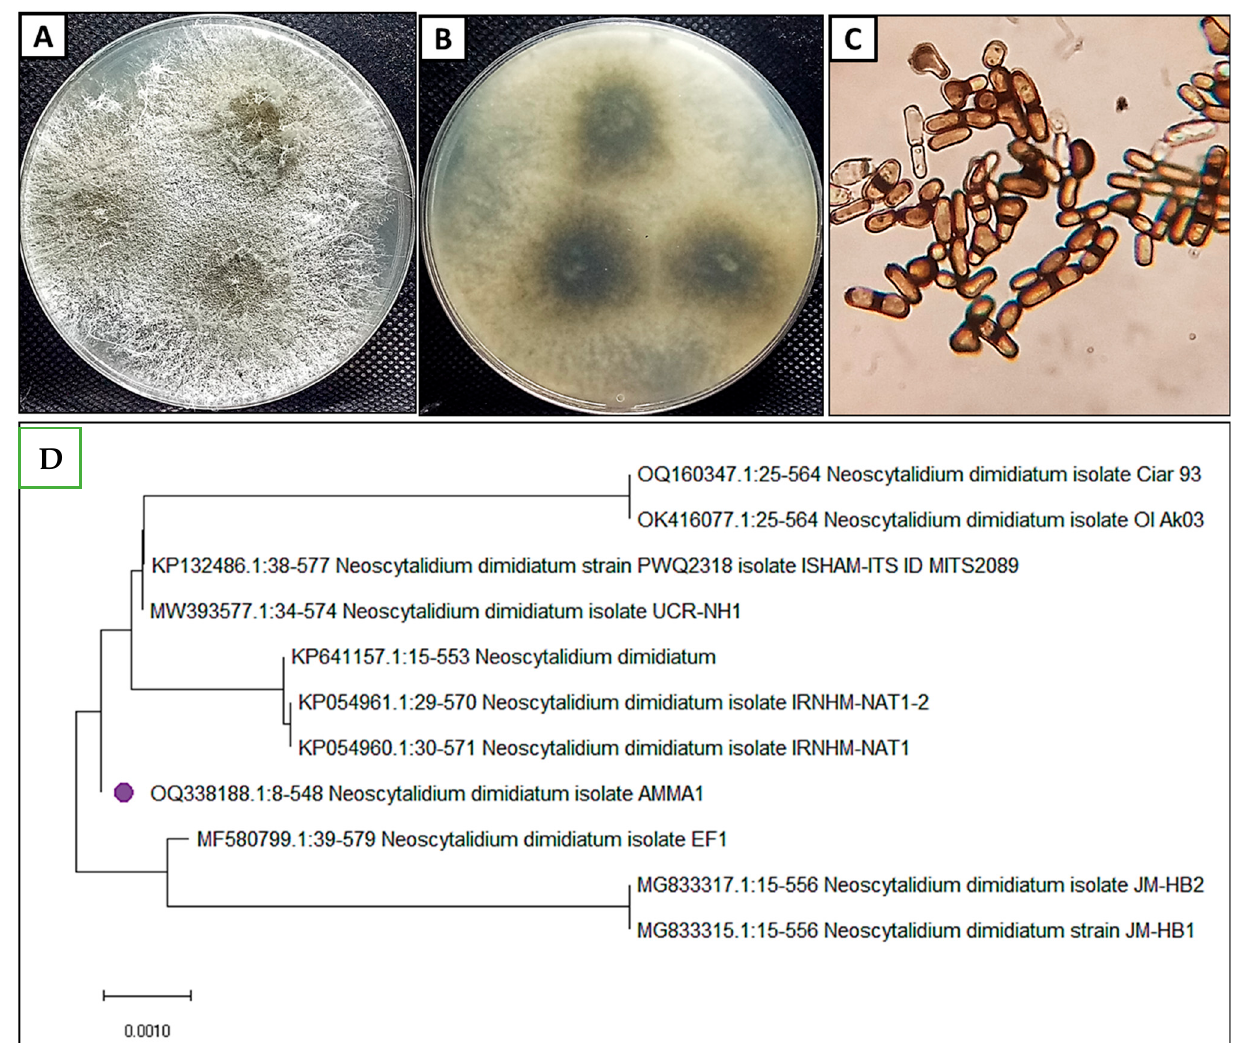
Figure 2. Identification of N. dimidiatum includes surface ( A ), reverse color and pigmentation on PDA ( B ), conidia under a light microscope ( C ), and a phylogenetic tree ( D ).